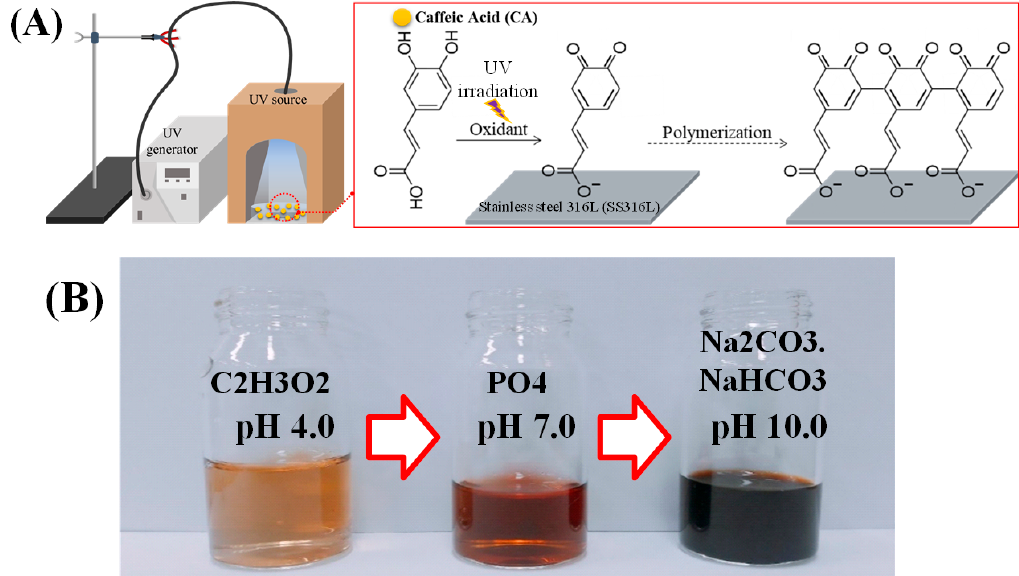
Figure 1. ( A ) Schematic illustration of the experimental setup for caffeic acid polymerization